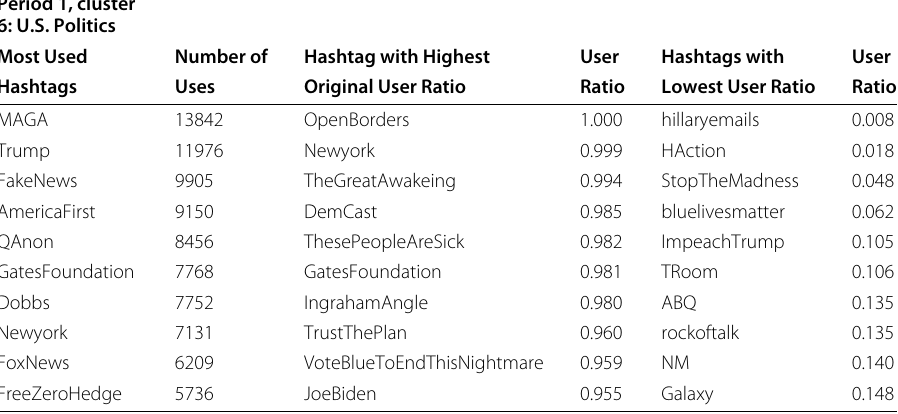
Table 6 Hashtags from period one cluster 6 which focuses on U.S. Politics related clusters Period 1, cluster 6: U.S.